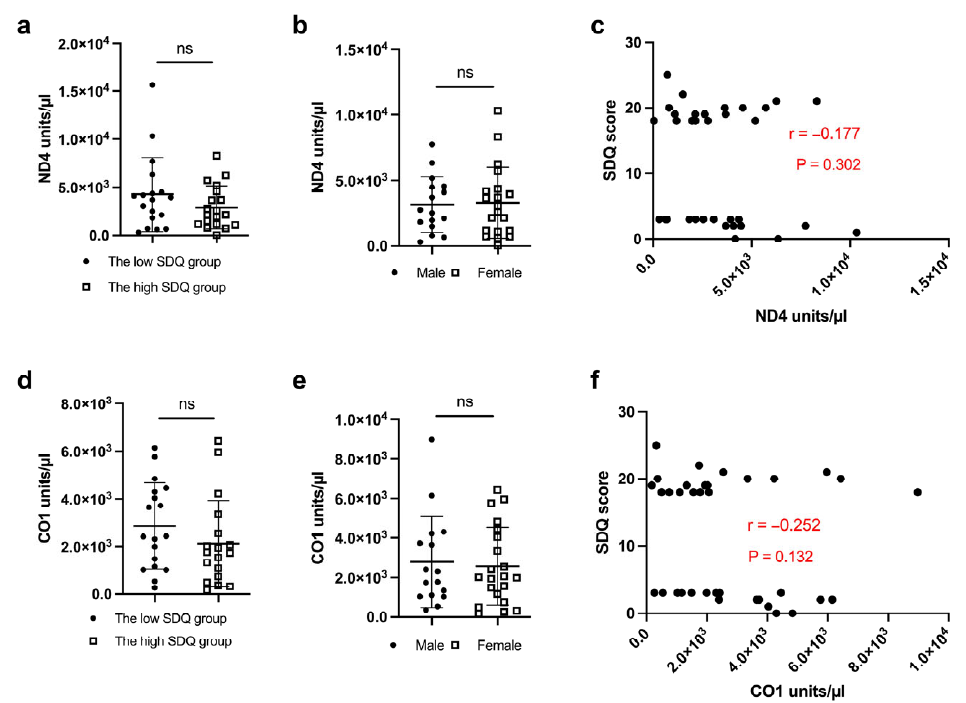
Figure 2. Comparison of plasma ccf-mtDNA unit levels between low and high SDQ groups, including sex-specific differences. ( a ) ND4 unit level in low ( n = 18) and high ( n = 19) SDQ groups, ( b ) ND4 unit level in males ( n = 16) and females ( n = 20), ( c ) interaction of the SDQ score with the level of ND4 units, ( d ) CO1 unit level in the low and high SDQ groups ( n = 18/group), ( e ) CO1 unit level in males ( n = 16) and females ( n = 21), ( f ) interaction of the SDQ score with the level of CO1 unit. Note: outliers were removed separately from each graph based on the used method. ns: non ‐ significant.